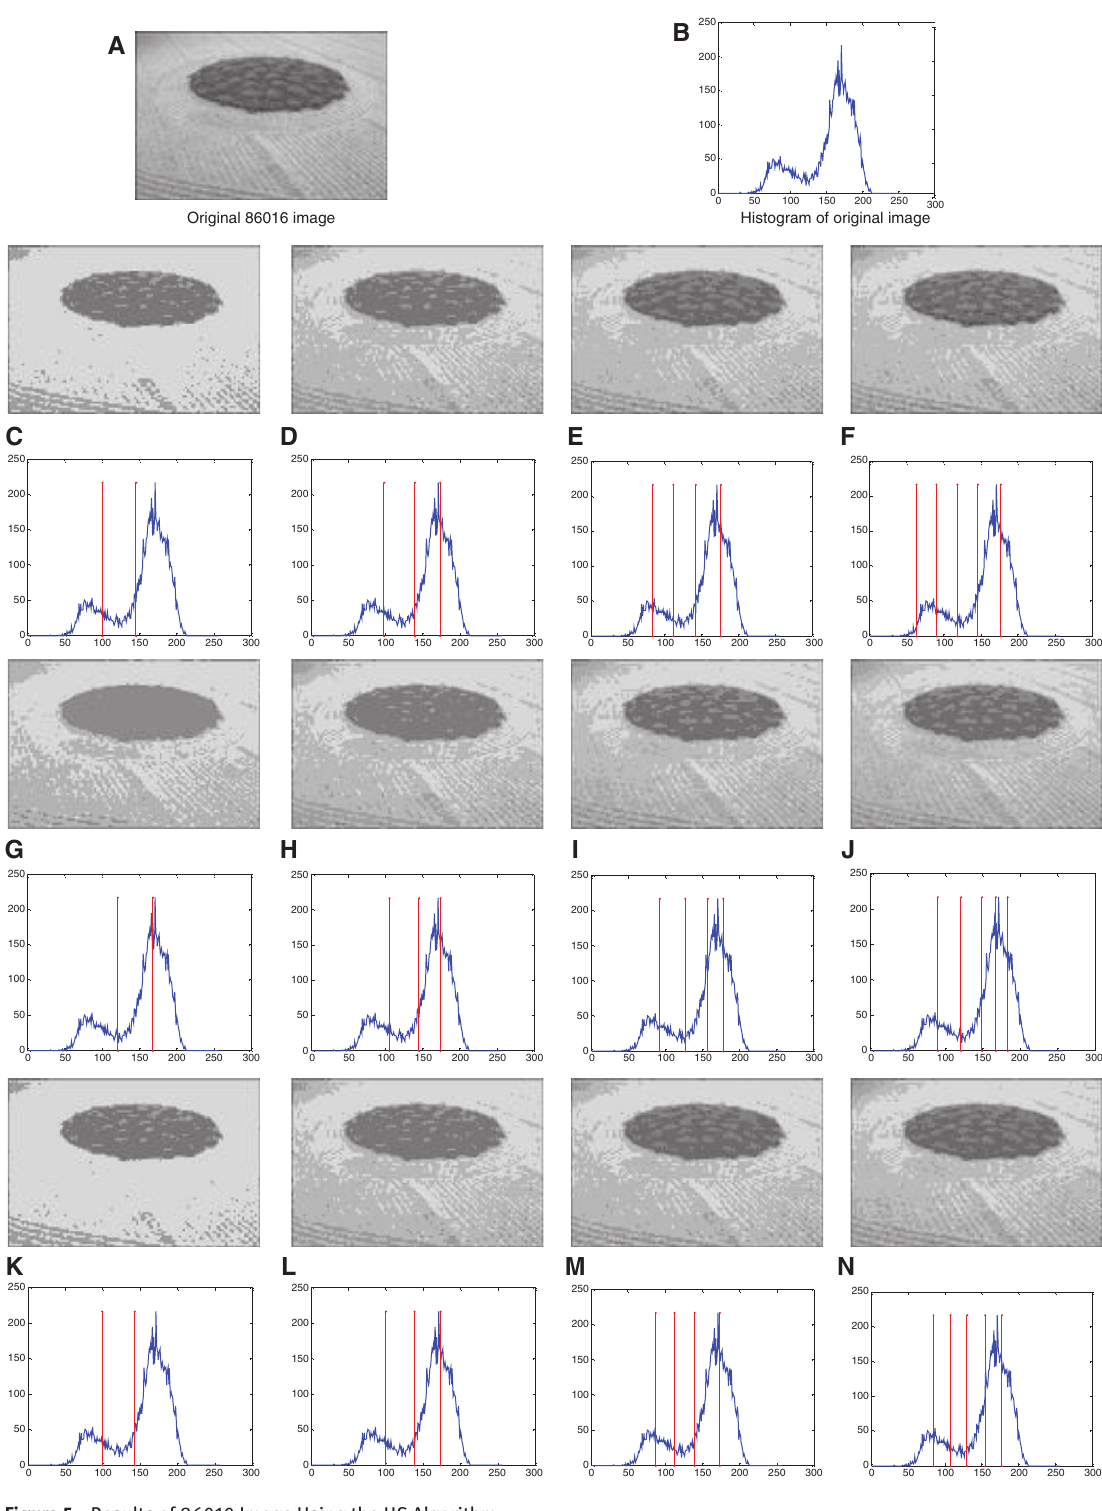
Figure 5: Results of 86010 Image Using the HS Algorithm. (A) Original 86010 image, (B) histogram of original image, (C–F) two-level to five-level thresholding-based segmented image with the best thresholds obtained from the HS algorithm using Kapur’s entropy criterion, (G–J) two-level to five-level corresponding histogram labeled with the best threshold values obtained from the HS algorithm based on the between-class variance criterion, (K–N) two-level to five-level thresholding-based segmented image with the best thresholds obtained from the HS algorithm using Tsallis entropy